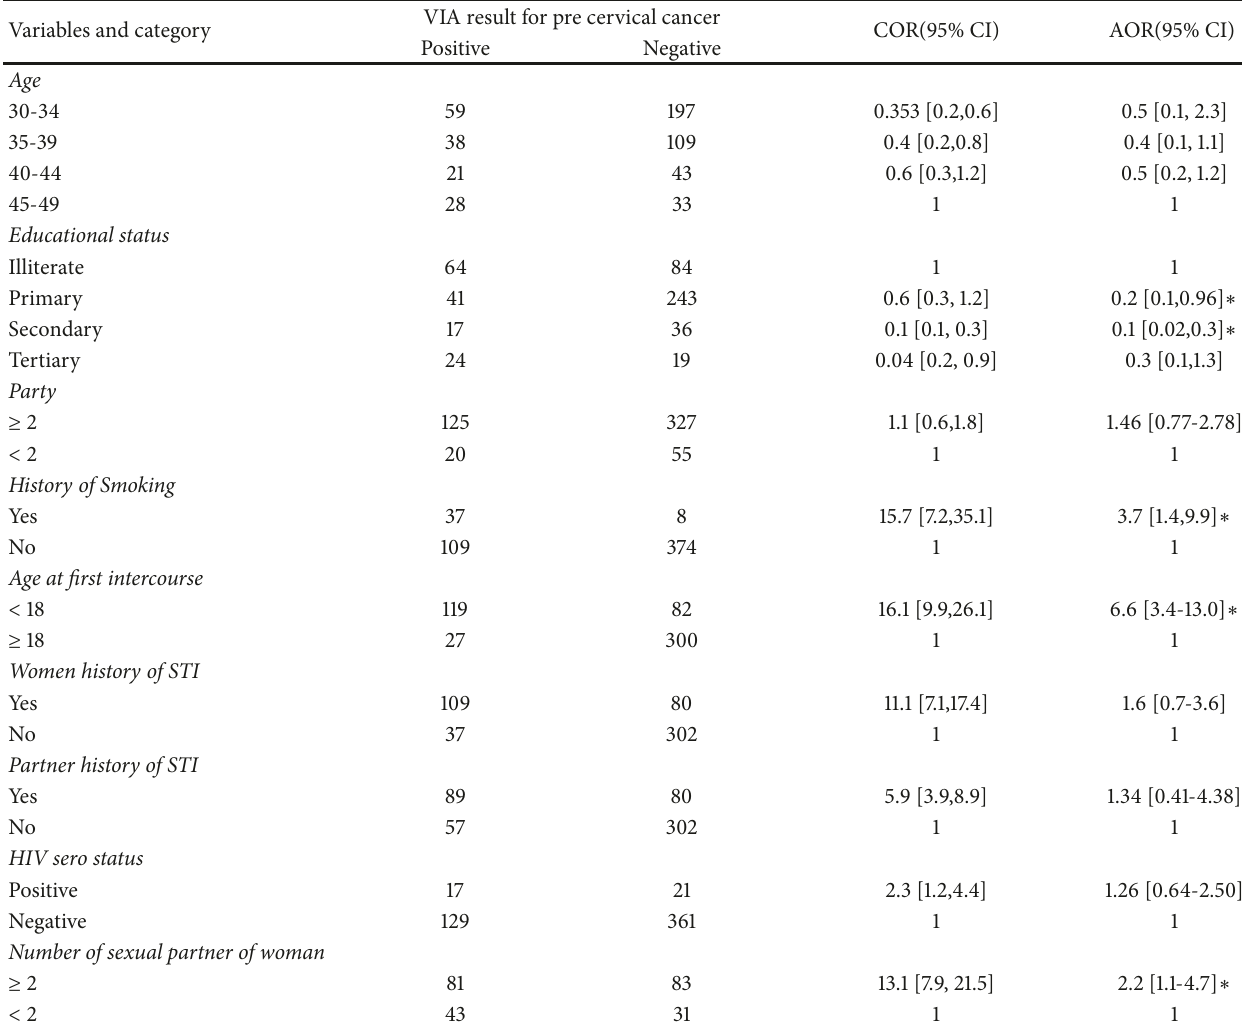
Table 4: Multivariable logistic regression analysis showing factors associated with precervical cancer among screened women in Arba Minch town and zuria district, Gamo Gofa zone, SNNPR, Ethiopia,